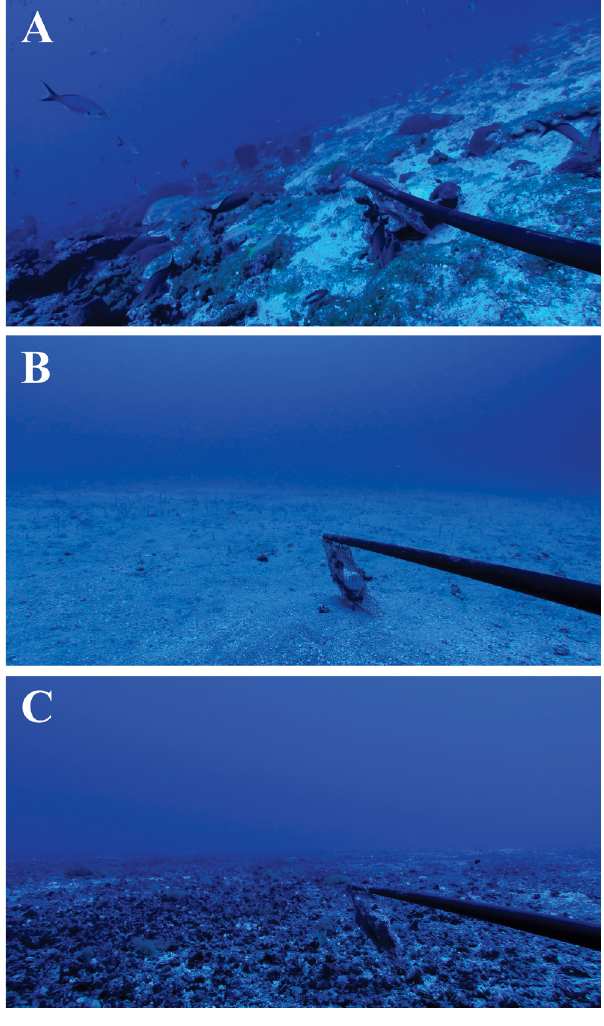
FIGURE 2 | Middle mesophotic (61 to 90 m depth) mosaic of habitats sampled with stereo-BRUVS around the Fernando de Noronha Archipelago. A. Patch reefs; B. Sand bottoms; and C. Rhodoliths beds.